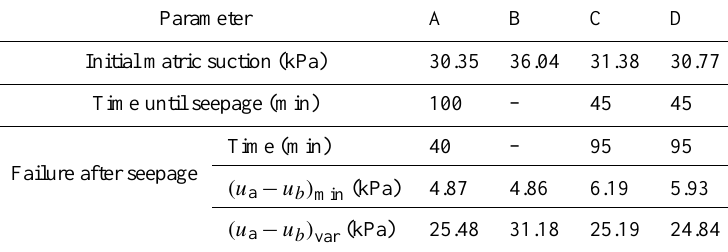
Table 6. Variation of matrix suction in the model slope of 70 ◦ inclination.